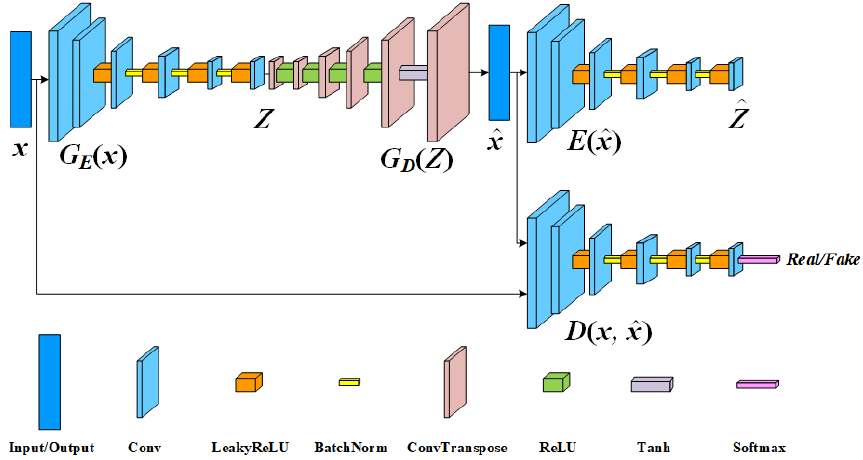
Figure 1. Network structure of GANomaly.